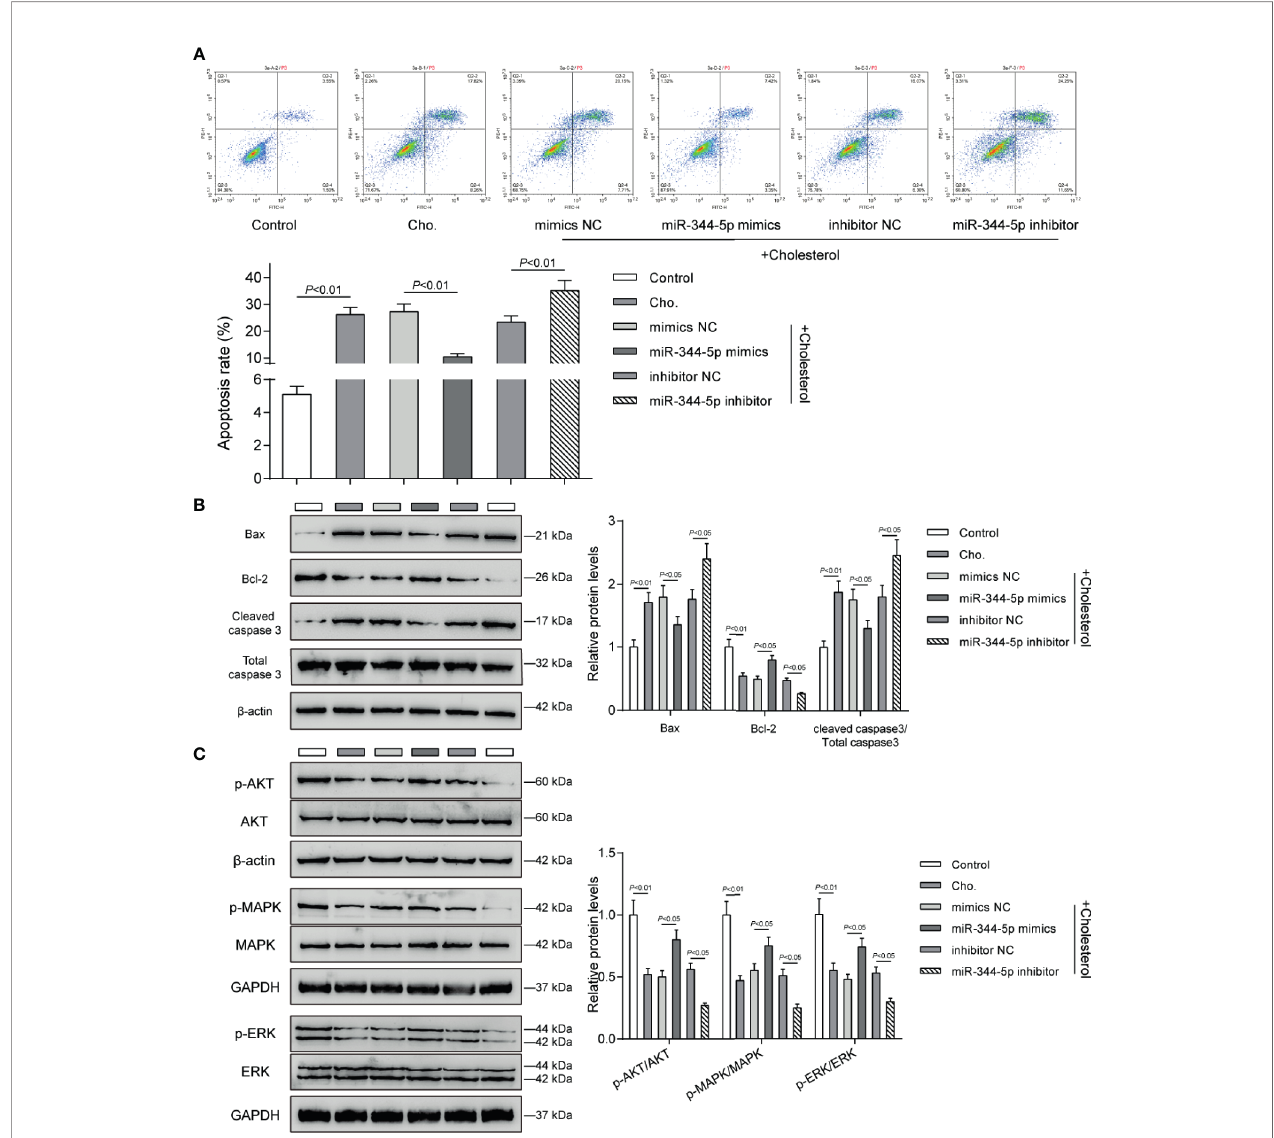
FIGURE 3 | miR-344-5p attenuates cholesterol-induced b -cell apoptosis and the MAPK/ERK signaling deregulation. Pancreatic b -cell line, INS-1, was transfected with miR-344-5p mimic or inhibitor for 48 h, treated with 5 mM cholesterol for 12 h, and examined for cell apoptosis by Flow cytometry assay (A) ; the protein levels of Bax, Bcl-2, and cleaved-caspase 3 by Immunoblotting (B) ; the protein levels of p-AKT, AKT, p-MAPK, MAPK, p-ERK, and EKR by Immunoblotting (C) . b -actin and GAPDH were applied as an endogenous